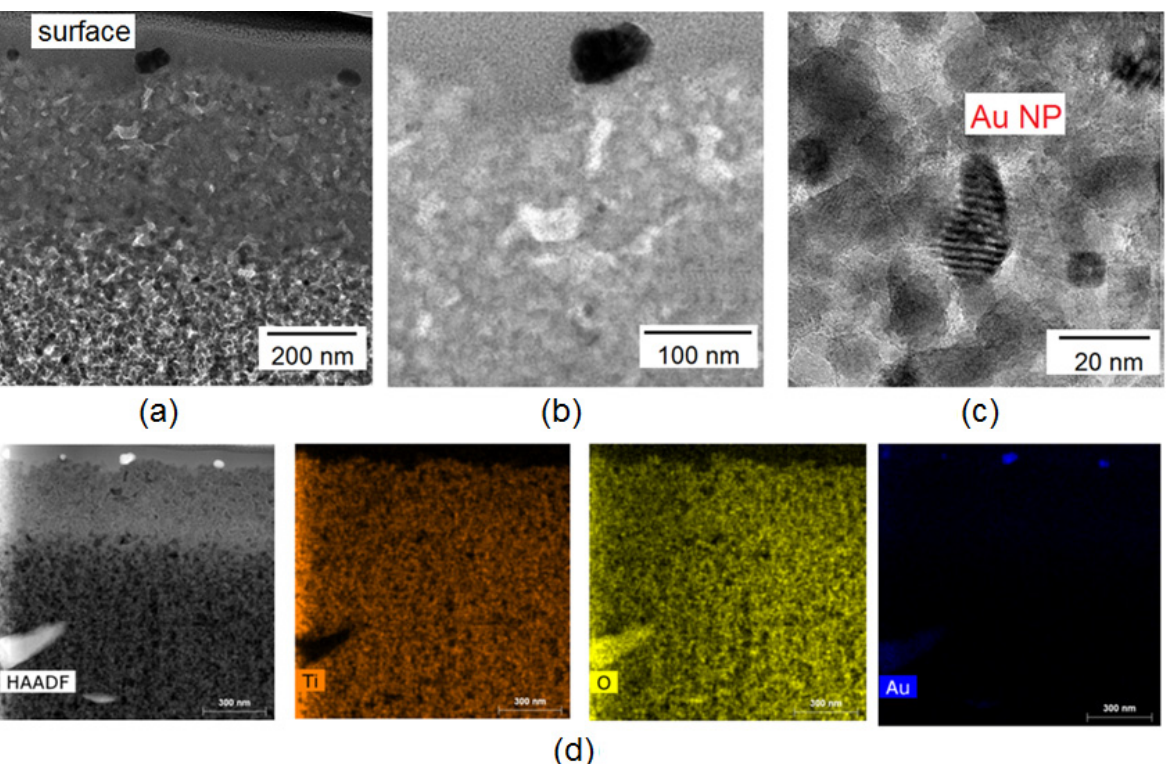
Figure 2. TEM images of the Au/TiO 2 layer in cross-section mode at various magnifications ( a – c ); EDS map of the Au/TiO 2 /FTO layer ( d ).